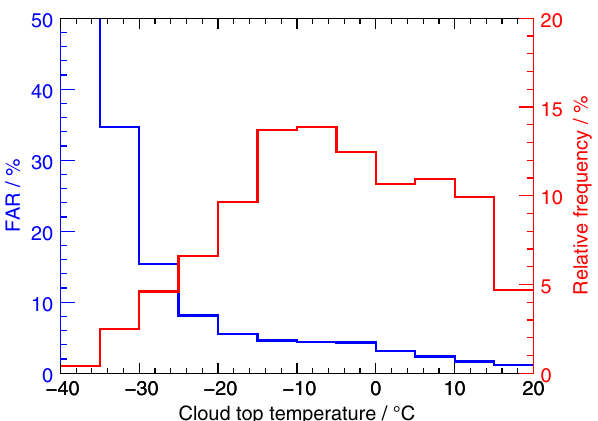
Figure 7. The FAR of CiPS for scenes with liquid water clouds (C5) as a function of the corresponding top temperature of the liquid wa- ter clouds. Along with the FAR, the relative frequency of occurrence of the different liquid water cloud top temperatures is shown.